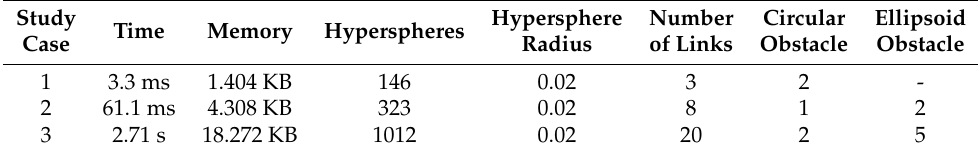
Table 4. Results obtained in the three case studies carried